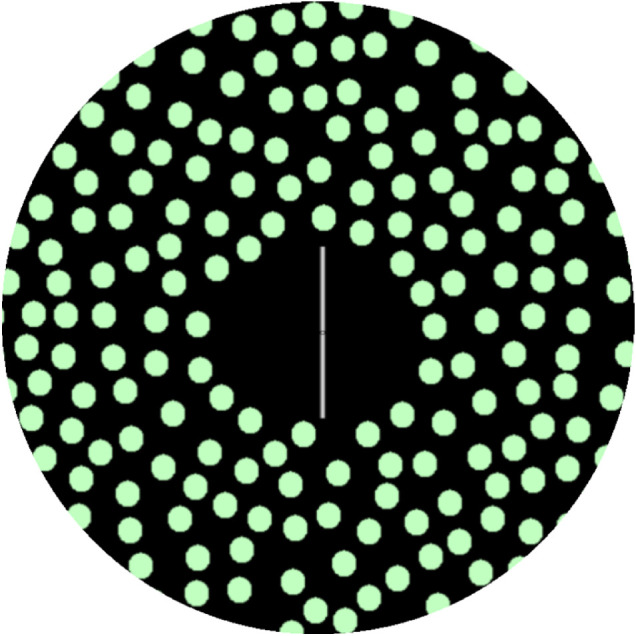
The target for the dynamic SVV. The circular discs moved clockwise at 30°/s. The task was to align the rod vertically from a starting orientation of random tilt.